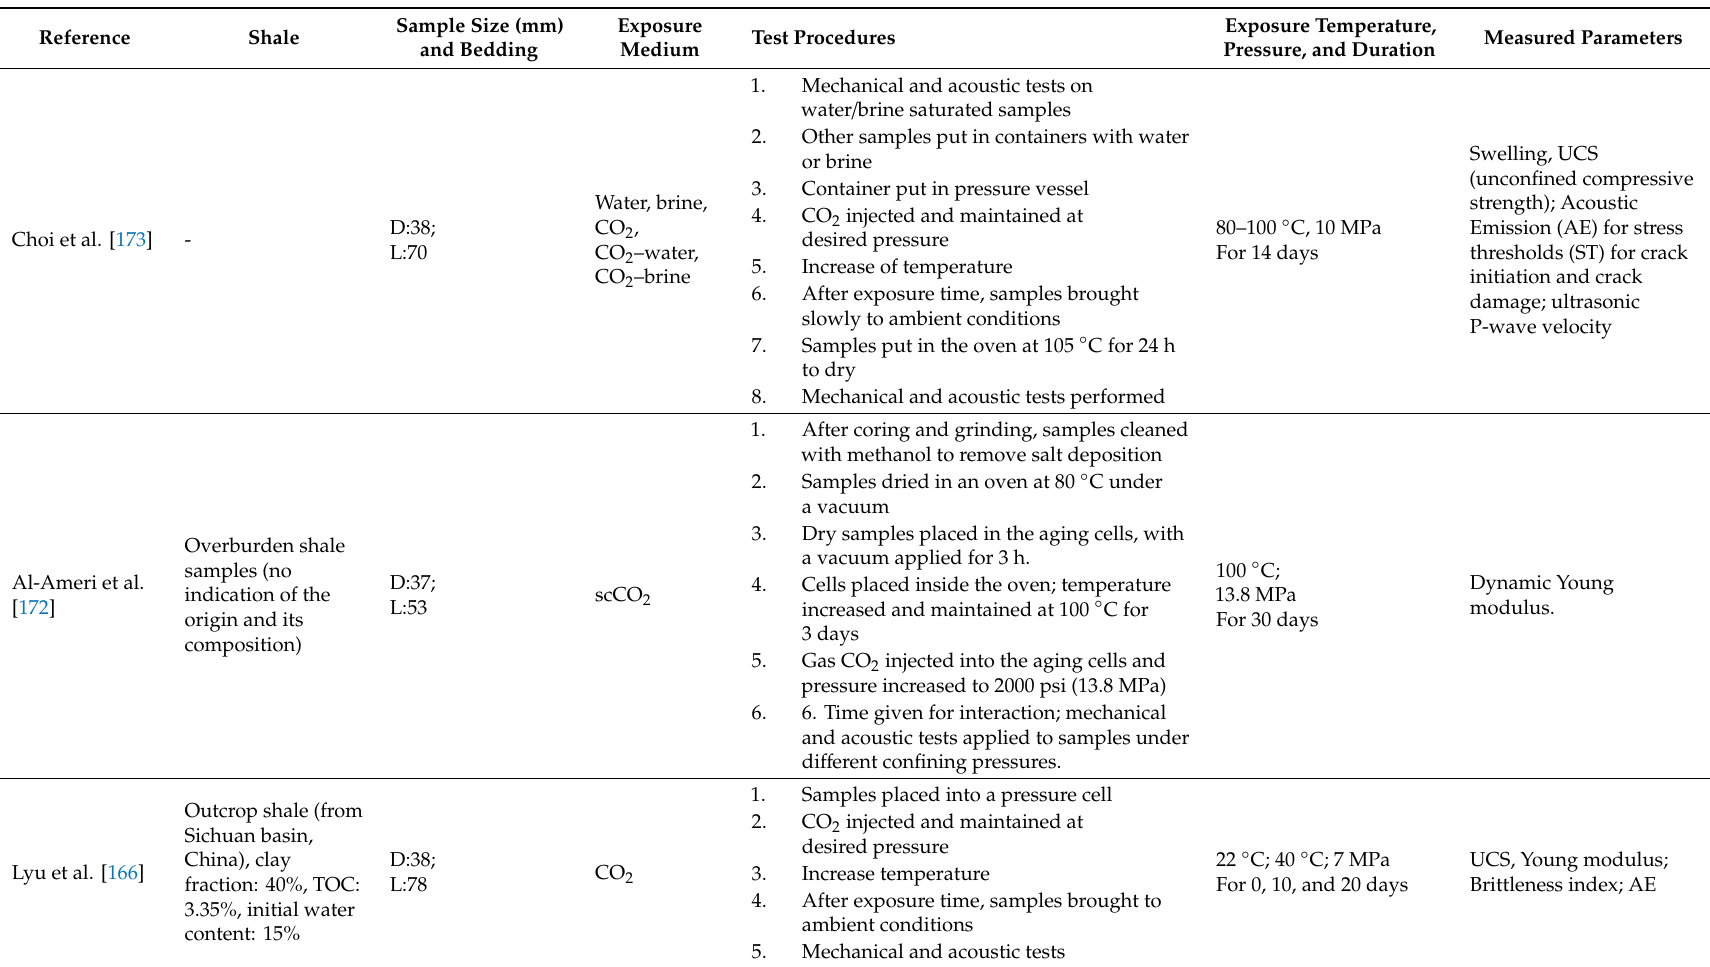
Table 1. Available experiments on the e ff ect of CO 2 on the mechanical properties of